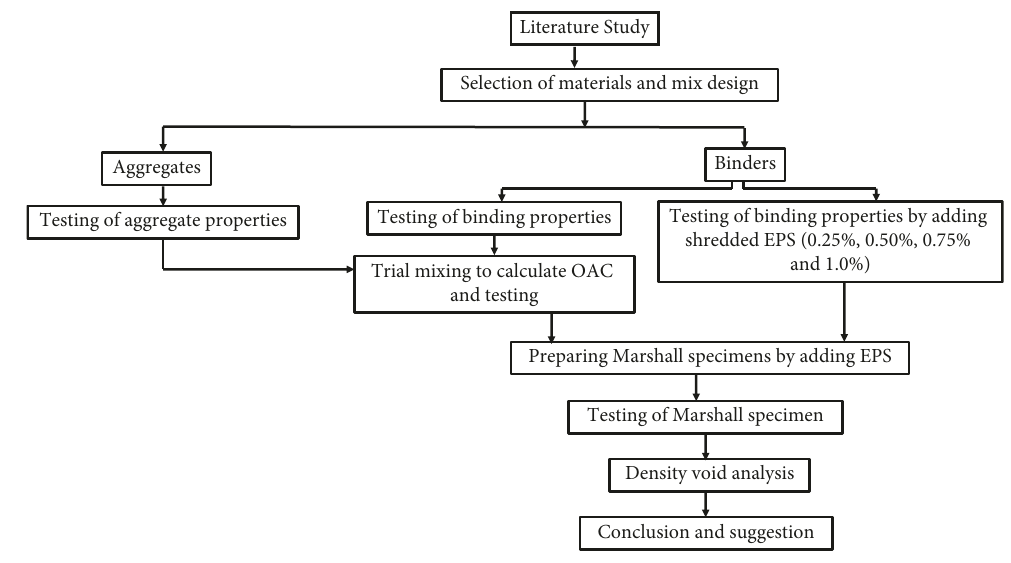
Figure 3: Marshall properties for control specimens. Table 4: Composition of